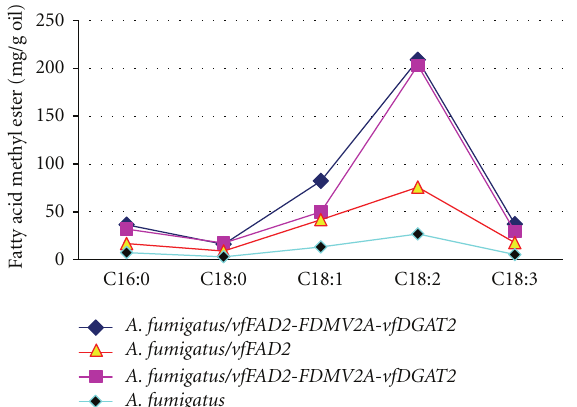
Figure 3: The fatty acid profile of A . fumigatus transformants containing vfFAD2 and vfDGAT2 . C16: 0, palmic acid; C18:0, stearic acid; C18:1, oleic acid; C18:2, linoleic acid; C18:3, linolenic acid. The two A . fumigatus transformants with vfFAD2-FDMV2A-vfDGAT2 showed a more than sixfold increase in linoleic acid production, while the transformant expressing vfFAD2 had about a twofold increase compared to the original A. fumigatus